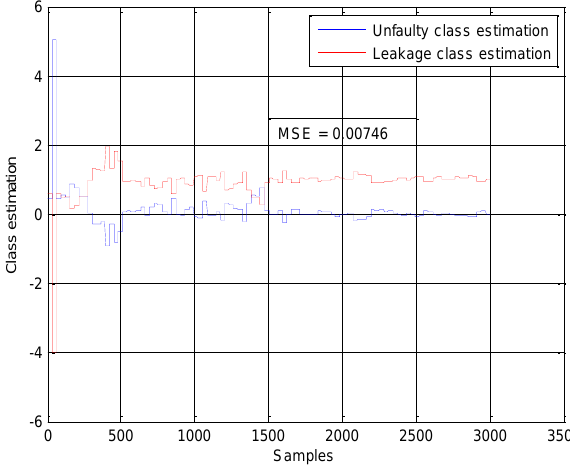
Figure 3. Engine_speed = 1000 rpm and torque = 130 Nm.